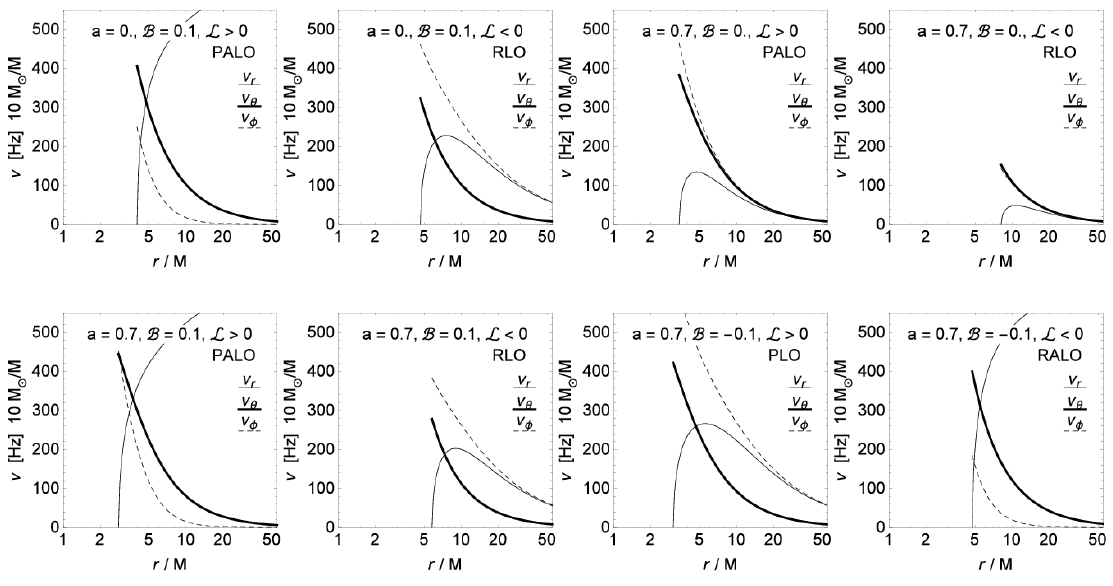
Figure 10. Radial profiles of the frequencies of small harmonic oscillations ν θ , ν r and ν φ of charged particle around Kerr black hole with mass M = 10 M (cid:12) and spin a in external magnetic field. The first row represents the influence of magnetic parameter B in the absence of rotation (first two figures) and rotation in the nonmagnetic case (last two figures). Second row represents the Kerr black hole with a = 0.7 with magnetic parameter B = ± 0.1 and Wald charge Q = Q W